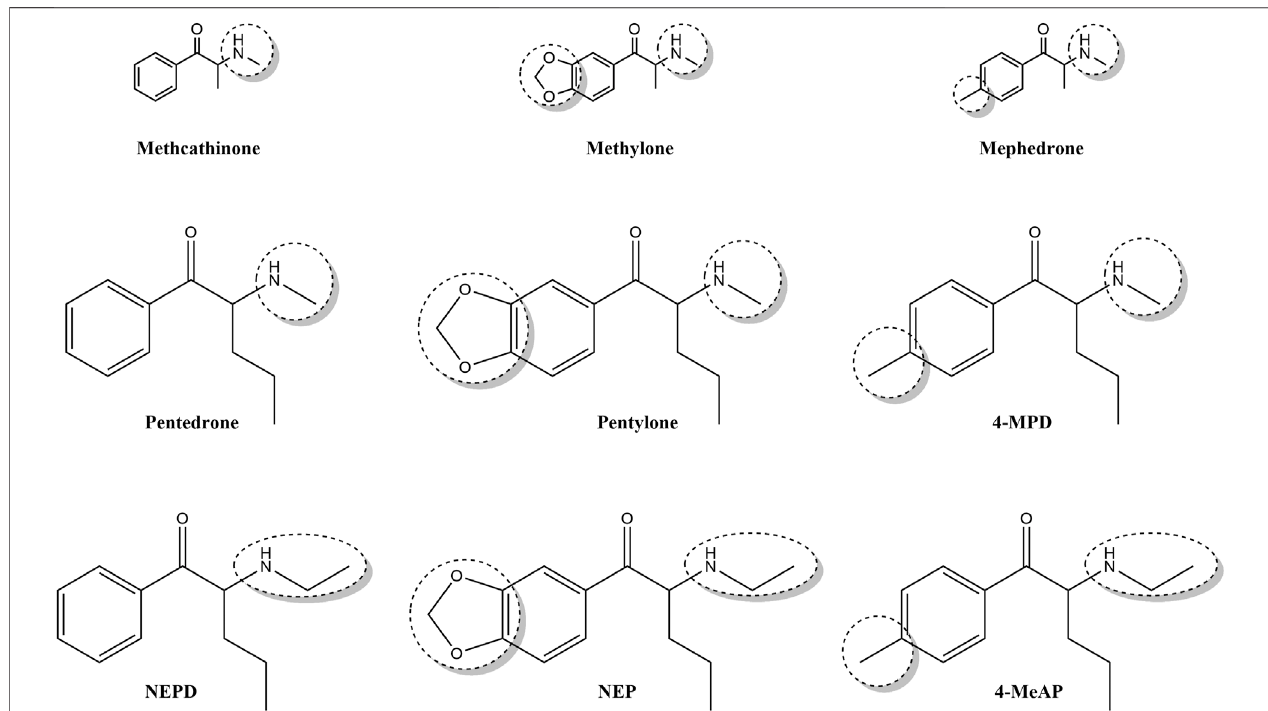
FIGURE 1 | Chemical structure of three fi rst-generation synthetic cathinones (methcathinone, methylone, and mephedrone) and six novel ring-substituted α -aminovalerophenone derivatives (pentedrone, pentylone, 4-MPD, NEPD, NEP, and 4-MeAP).